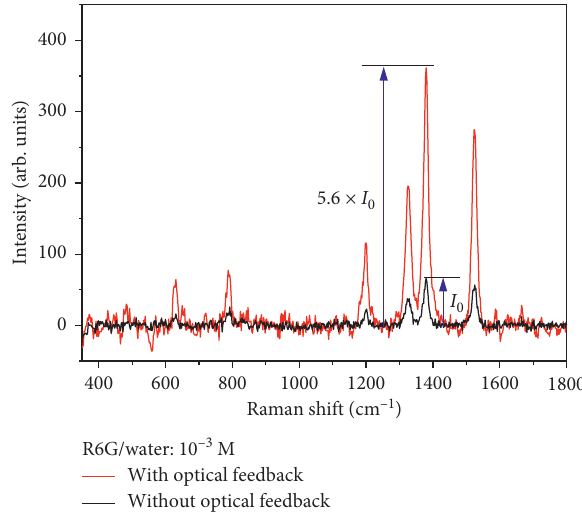
Figure 5: Raman-scattering spectra measured on R6G/water so- lution with a concentration of 10 − 3 Mol/L using a system with (red) and without (black) an “ F+2f ” optical feedback